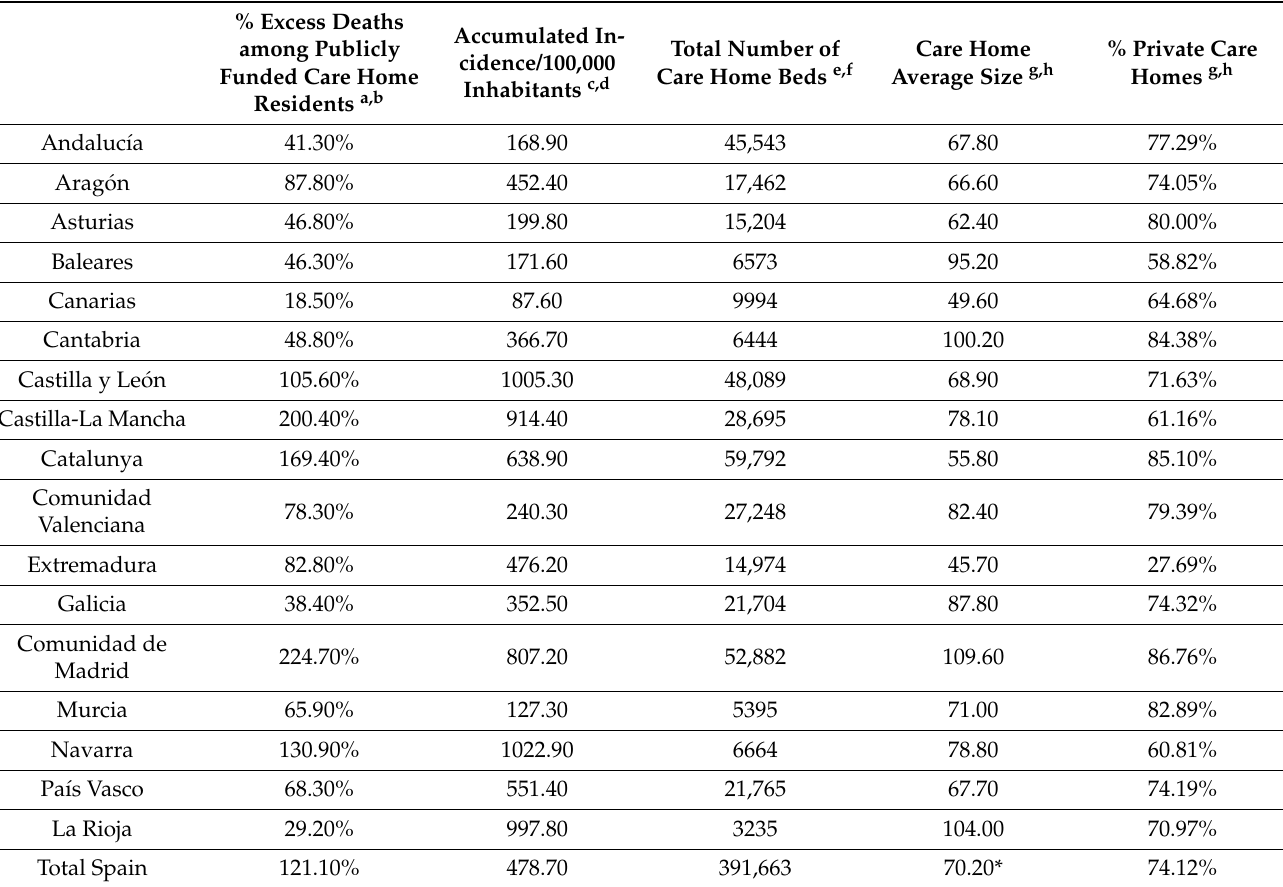
Table 2. Excess deaths among care home publicly funded bed beneficiaries and characteristics of care homes in Spain disaggregated by Autonomous